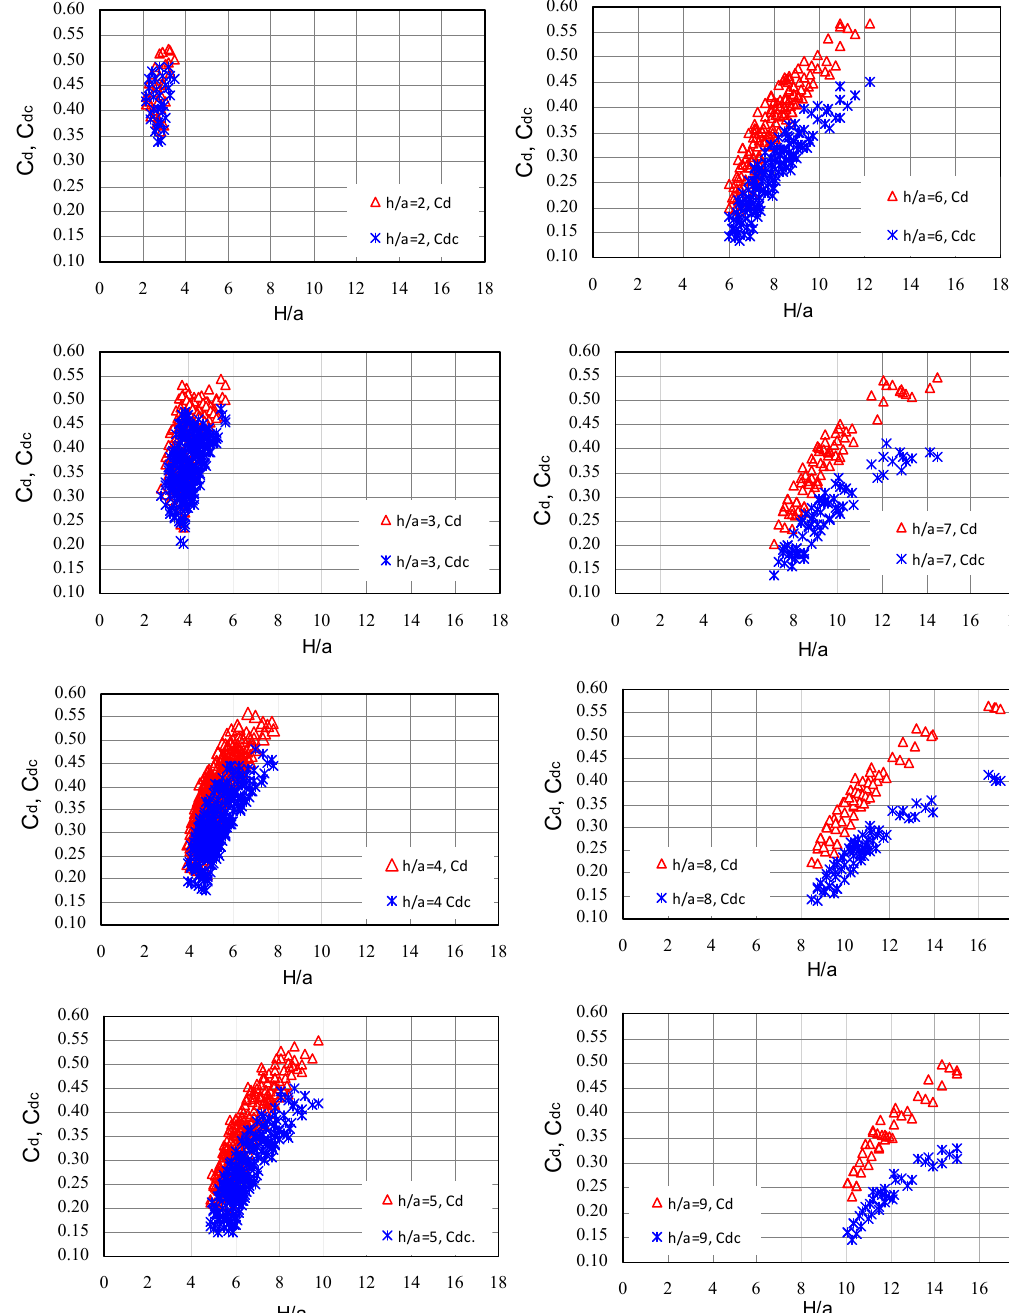
Figure 9. Discharge coefficients C d calculated on the basis of measurements in experiments in the V2 case and from the Swamee [10] C dc relationship (5).